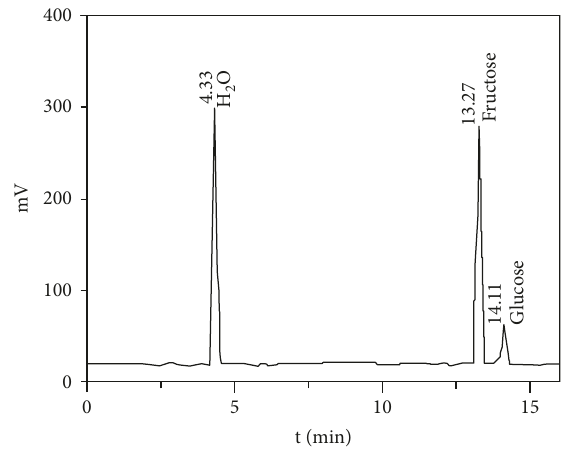
Figure 1: HPLC analysis of the ratio of fructose to glucose in hydrolyzed Achyranthes polysaccharides extracted Acetyltalatisamine Achyranthan was hydrolyzed, and the ratio of fructose to glucose was measured. From the data, we know that at about the 13th minute fructose was separated and glucose was separated at the 14th minute. The ratio of the two was about 4 to 1 (fructose to